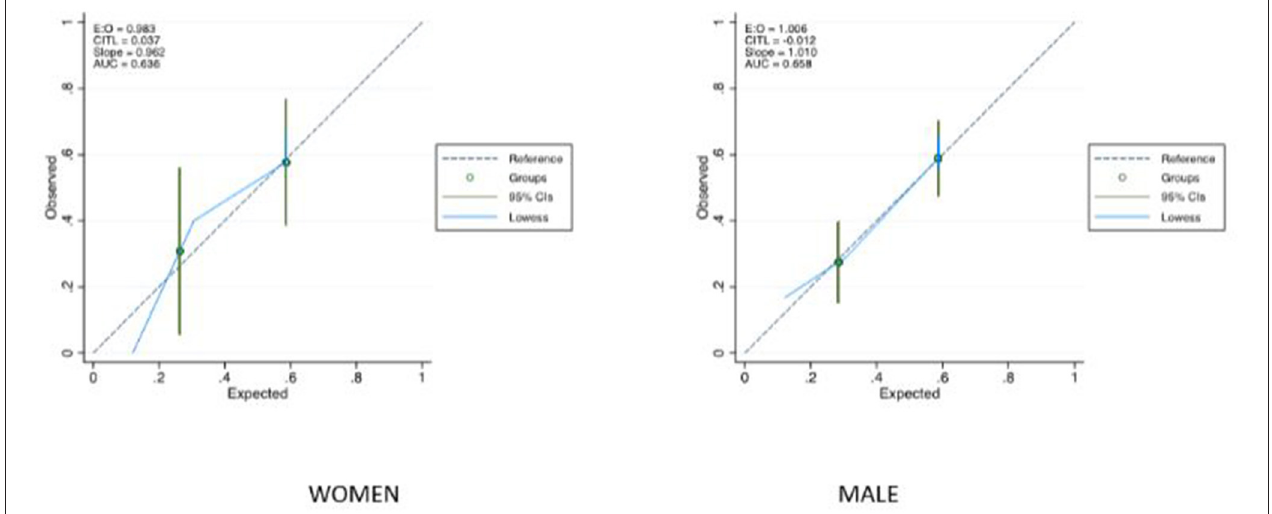
FIGURE 4 | Calibration of SCAI